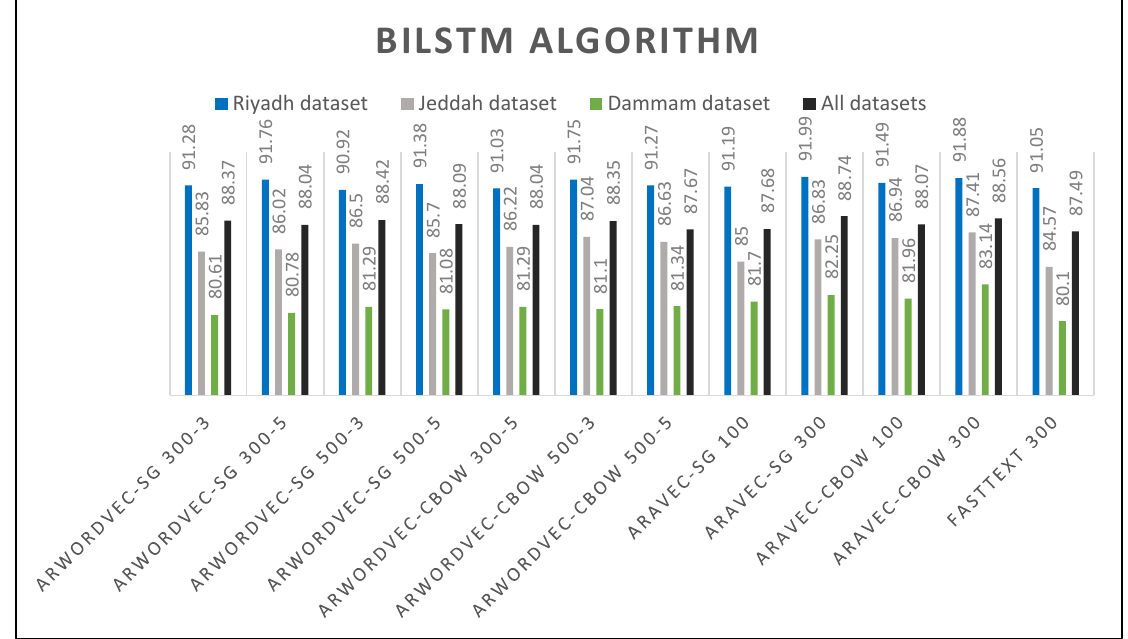
Figure 8. The Accuracies metric of BiLSTM algorithm for comparing different Arabic pre-trained word embedding techniques for dataset before